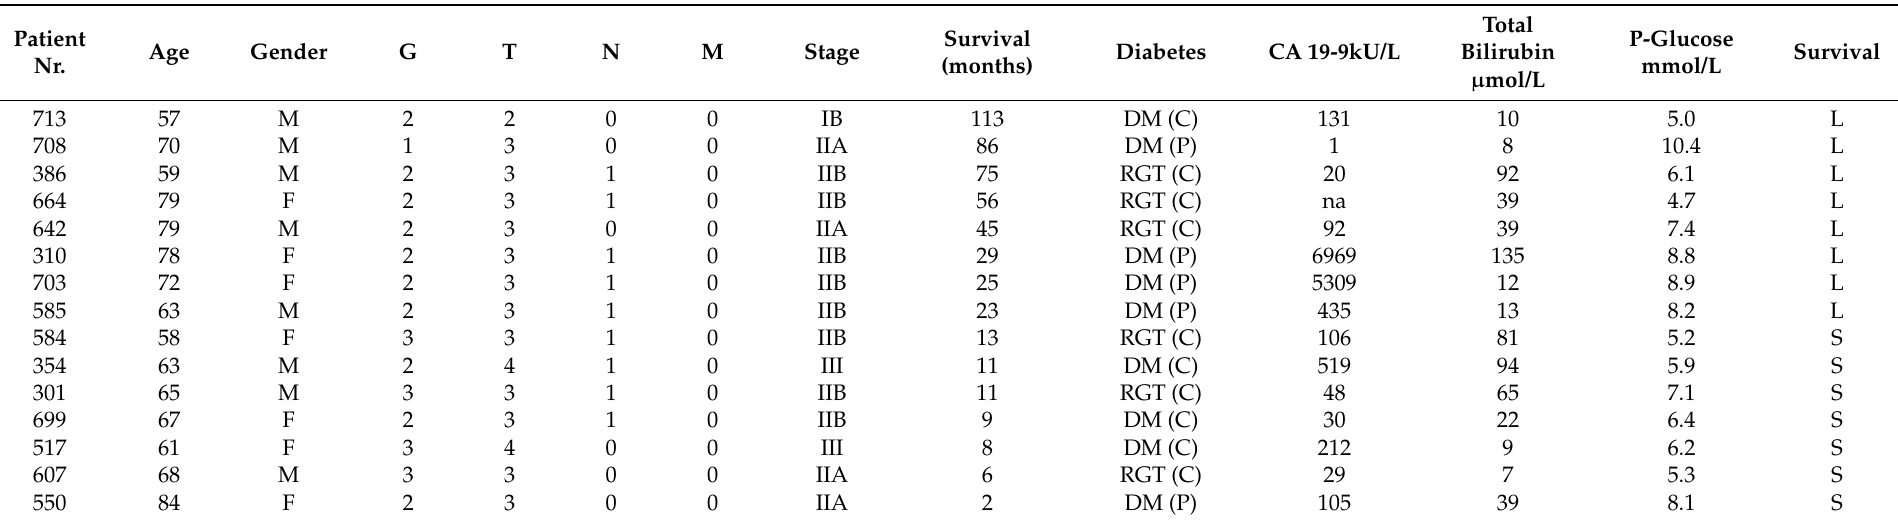
Table 1. Clinical and biochemical characteristics of PDAC patients included in the